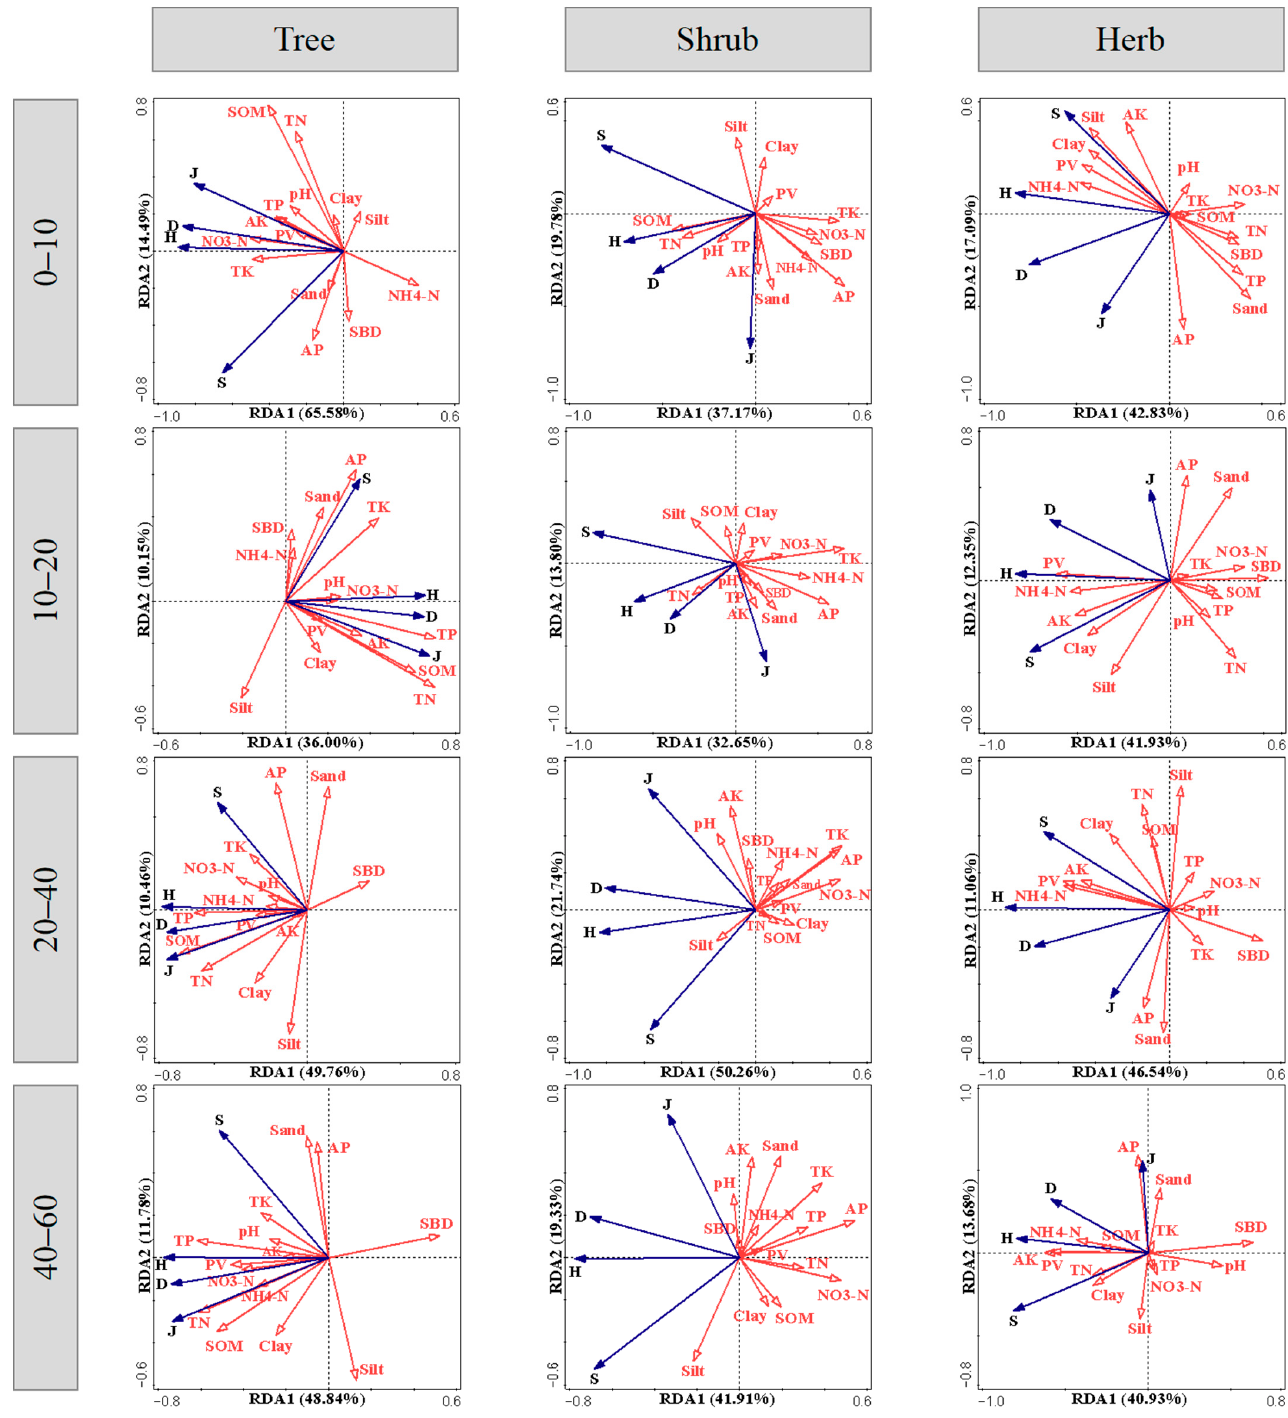
Figure 8. Redundancy analysis of soil physicochemical properties and diversity indexes of trees, shrubs and herbs. Each vertical row depicts the same plant layer, and each horizontal row depicts the same soil layer.